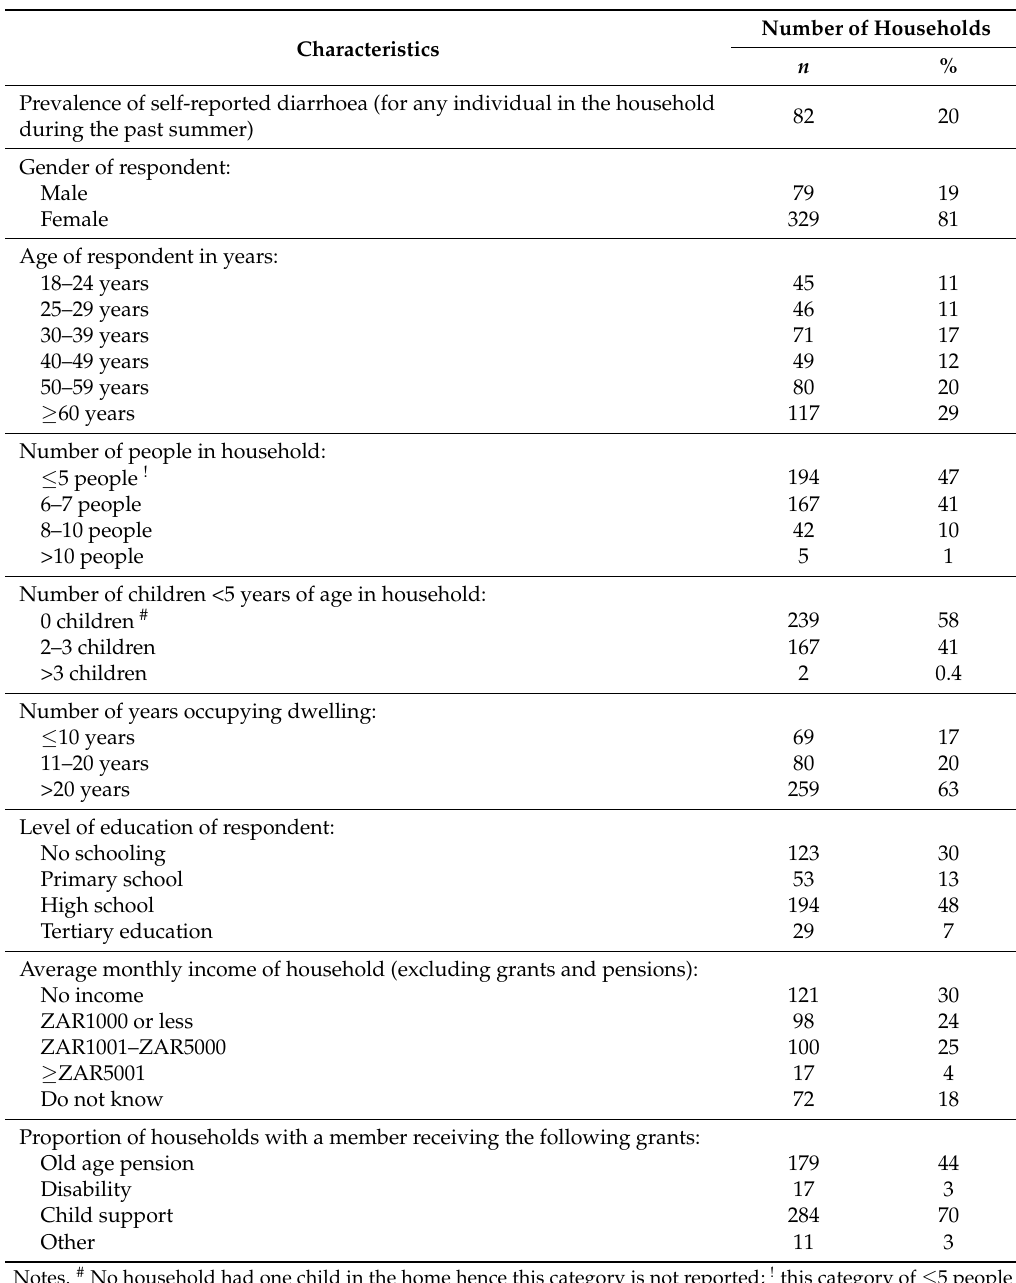
Table 1. Prevalence of primary caregiver-reported diarrhoea and demographic characteristics of households ( n = 408). Characteristics